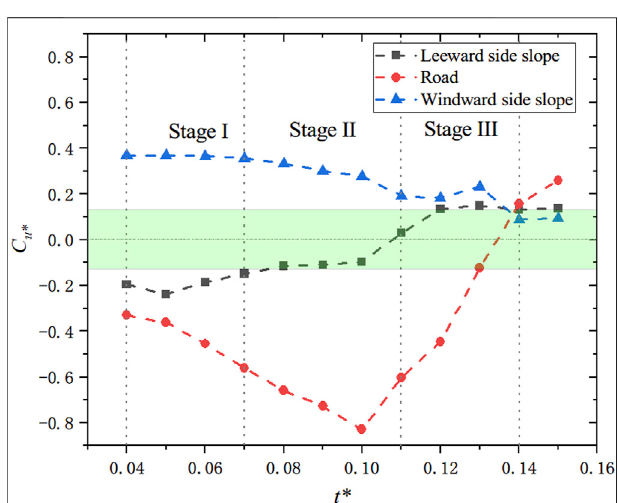
FIGURE 11 | Snow variation coef fi cient at the different stages. The variation of u* on both sides ofslope and road surface isanalyzedasshown in Figure 10 . The snow deposition rate can be analyzed from the fi gure, which has different characteristics on road surface and slope. The windward- side slope is the most stable and has been in a state of snow erosion. In the beginning, the leeward side slope was in a state of snow deposition. After the emergence of the secondary vortex, it also entered a relatively stable state. The change of road surface is the most dramatic, and the snow deposition rateincreasesalmost allthetime